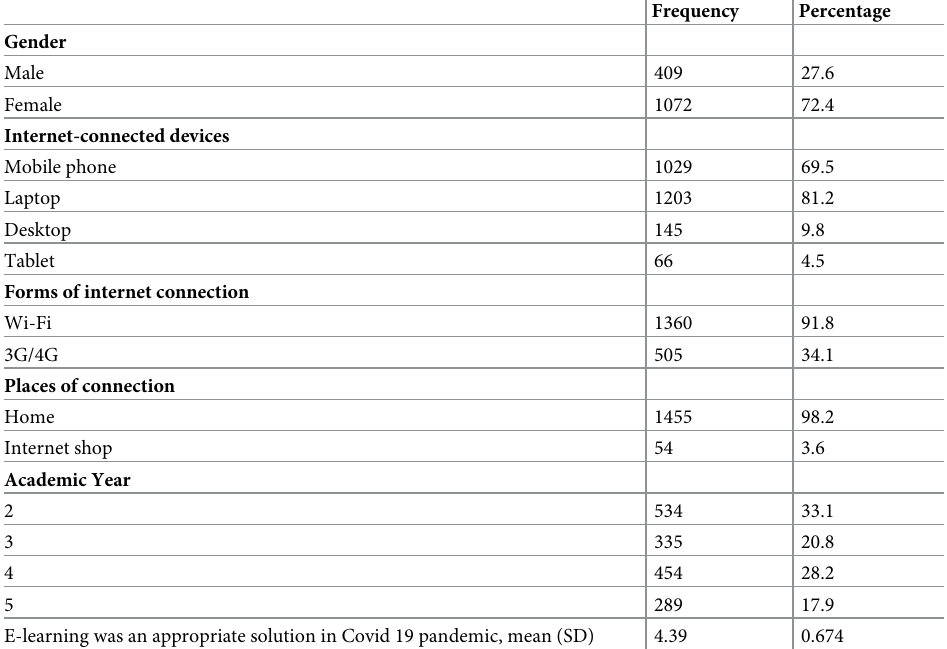
Table 1. The demographic characteristics of the participants.